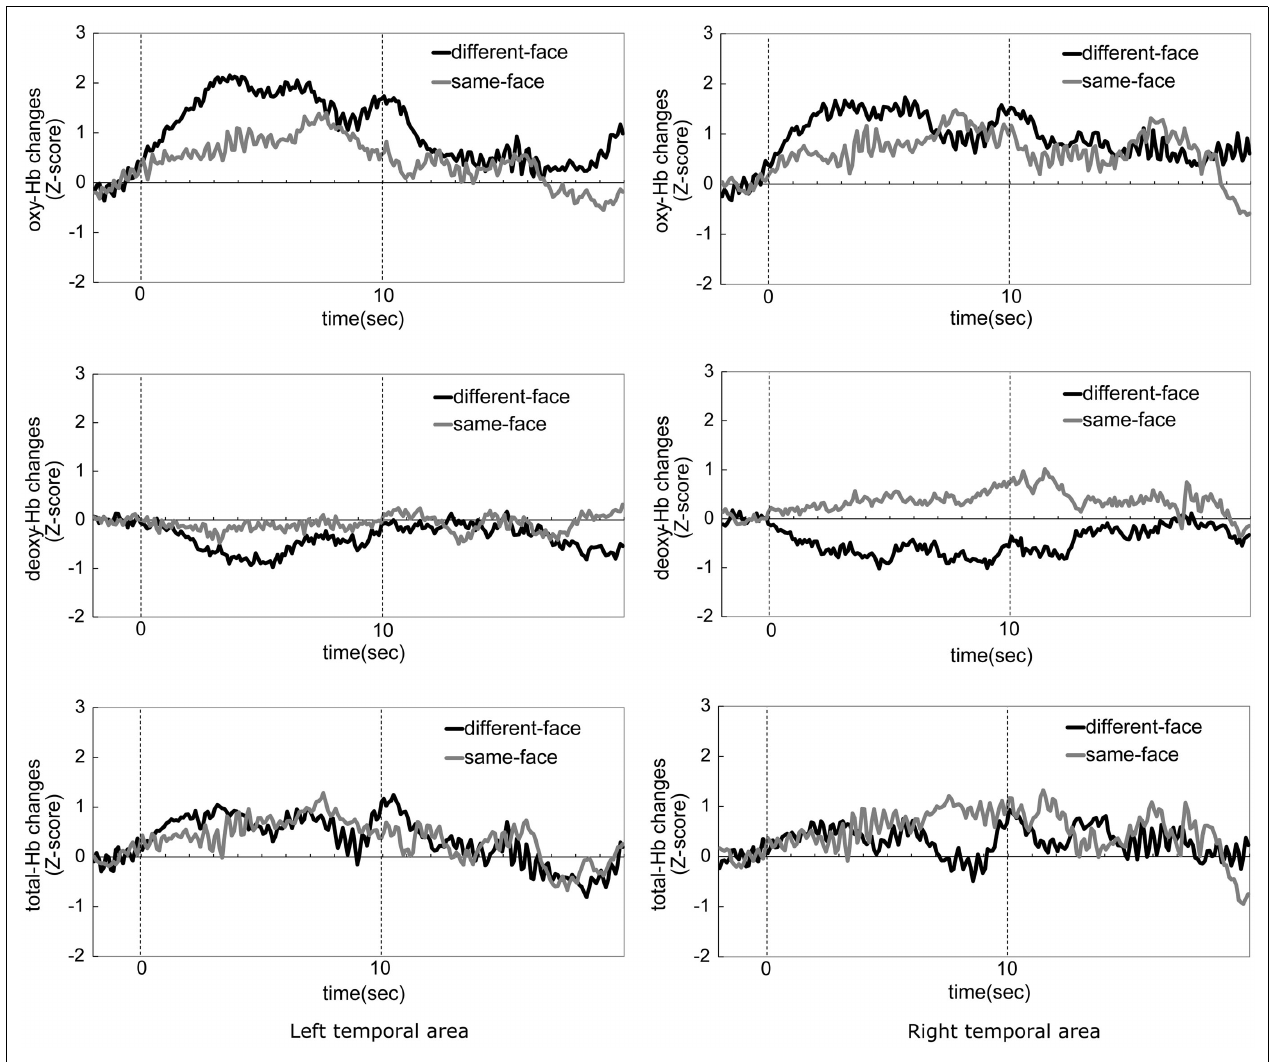
area.The black line in the graph represents the mean Z -score of the different-face condition, and gray line represents the mean Z -score of the same-face condition. Zero on the horizontal axis represents the beginning of the test period and 10 on the horizontal axis represents the end of the test